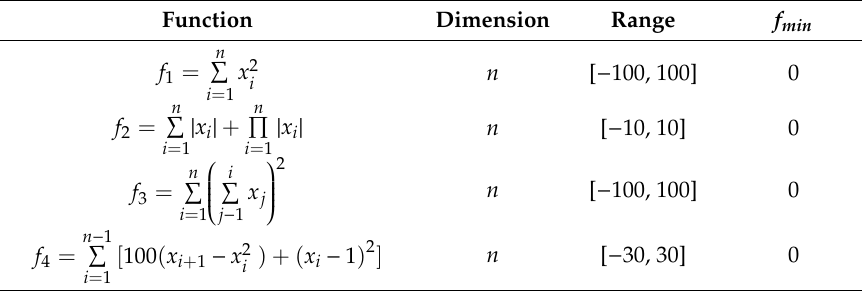
Table 6. Four benchmark test functions [92].